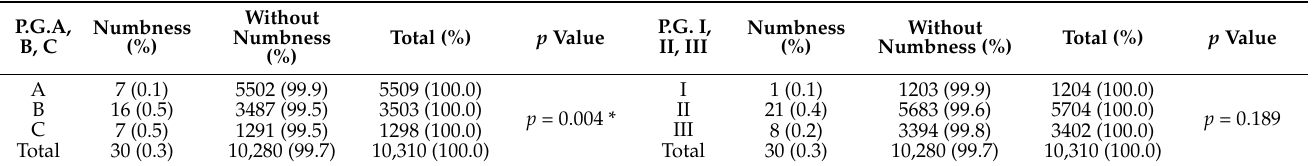
Table 13. Association between the Pell and Gregory classification (P.G.) and numbness.